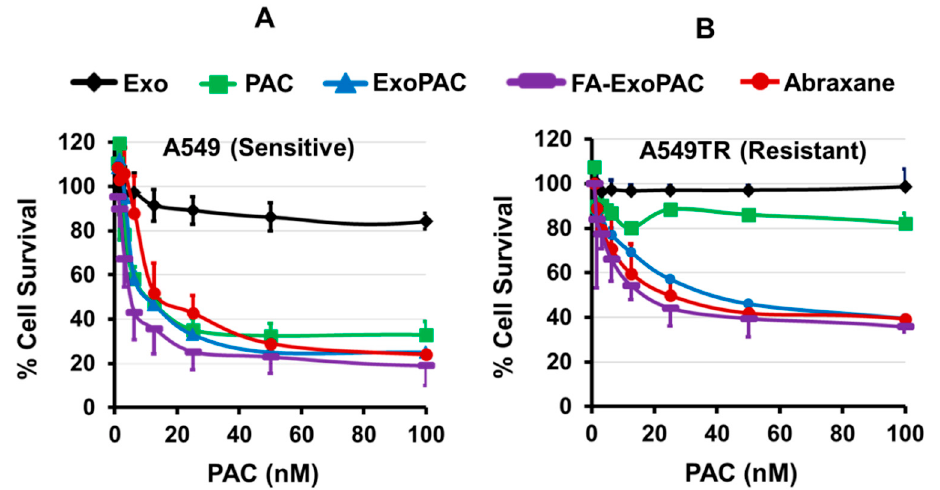
Figure 2. ExoPAC inhibits proliferation of drug-sensitive and drug-resistant cells. ( A ) Drug-sensitive (A549) and drug-resistant (A549TR) cells were treated with Exo, ExoPAC and FA-ExoPAC and compared with Abraxane. Antiproliferative activity was determined by MTT assay after 72 h. Exosomal PAC dose-dependently inhibited the proliferation of drug-sensitive A549 ( A ) and drug-resistant A549TR cells ( B ).